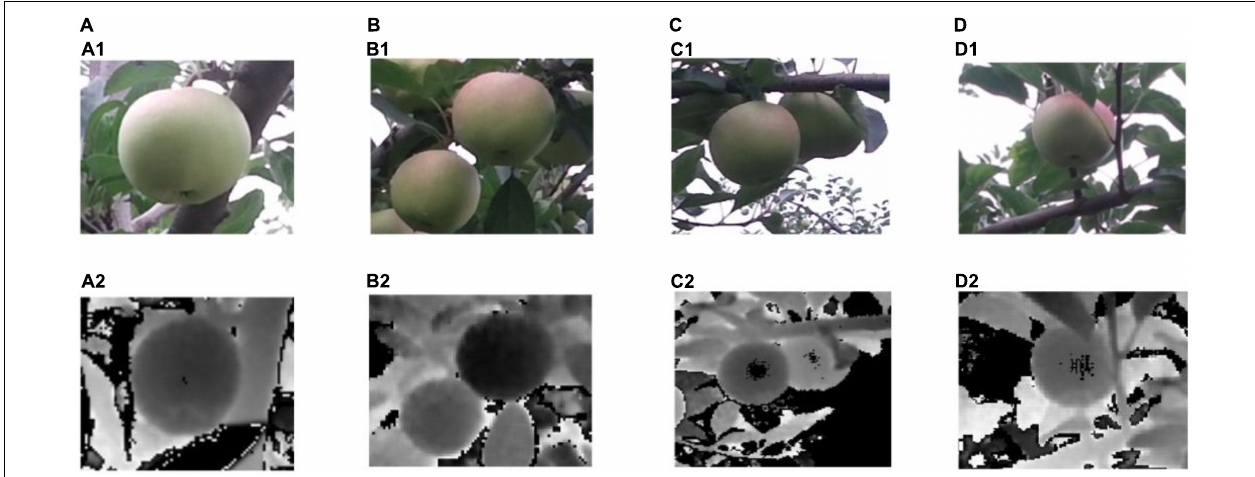
FIGURE 1 | Apple images of RGB and depth images collected at the same sample point (note: panels (A,B) are single fruits without obscured; (C) are overlapping fruits; (D) are occlusion fruits; top images of every group represent the RGB image and bottom images represent depth images). The number of images: This study collected a total of 300 sample points data, including 300 depth images and 300 RGB images and containing 526 target fruits in the dataset.